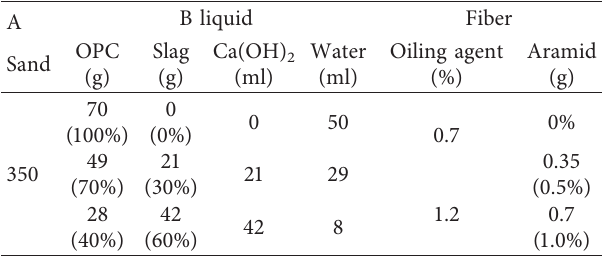
Figure 2: Particle size distribution curve of sand. Table 2: Mixing ratio for measurement of uniaxial compression strength of grout materials using aramid fiber.